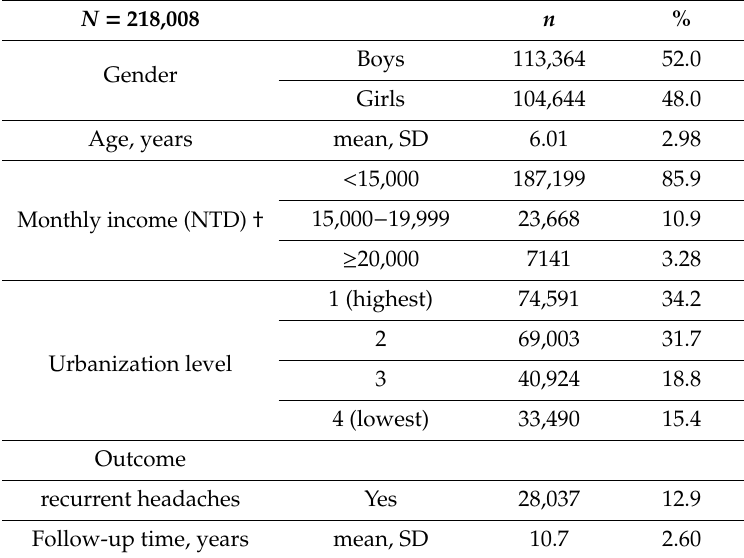
Table 1. Sociodemographic data of the study